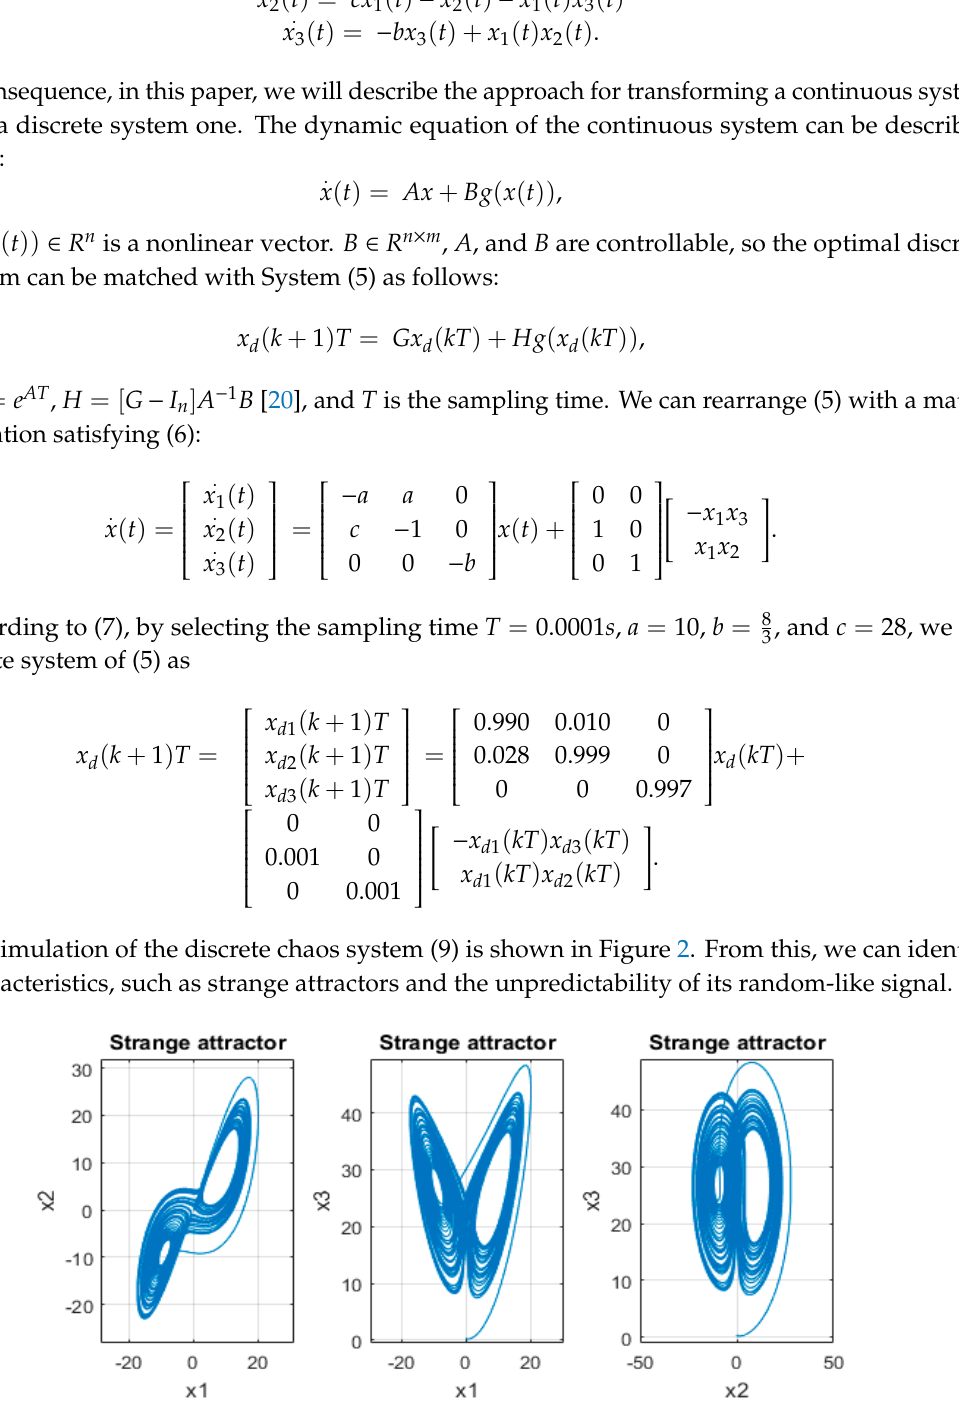
Figure 2. Strange attractors of the discrete Lorenz system (9).